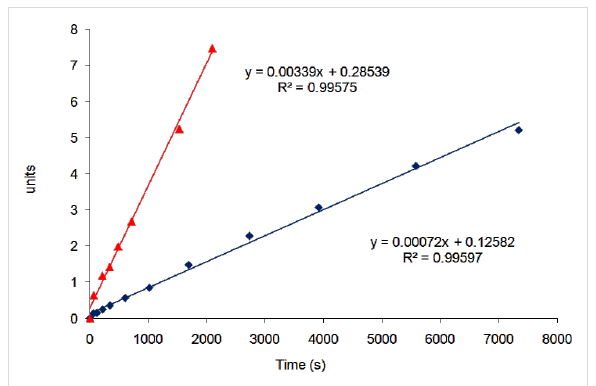
Figure 2: Second-order kinetics plot for the addition of TMSCN to benzaldehyde at 0 °C catalysed by complex 2 in dichloromethane (red) and propylene carbonate (blue). The units for the vertical scale are ln[(B 0 A t )/(B t A 0 )]/(A 0 –B 0 ), where A = [PhCHO], B = [Me 3 SiCN], and the subscripts 0 and t refer to initial concentrations and concentrations at time t ,